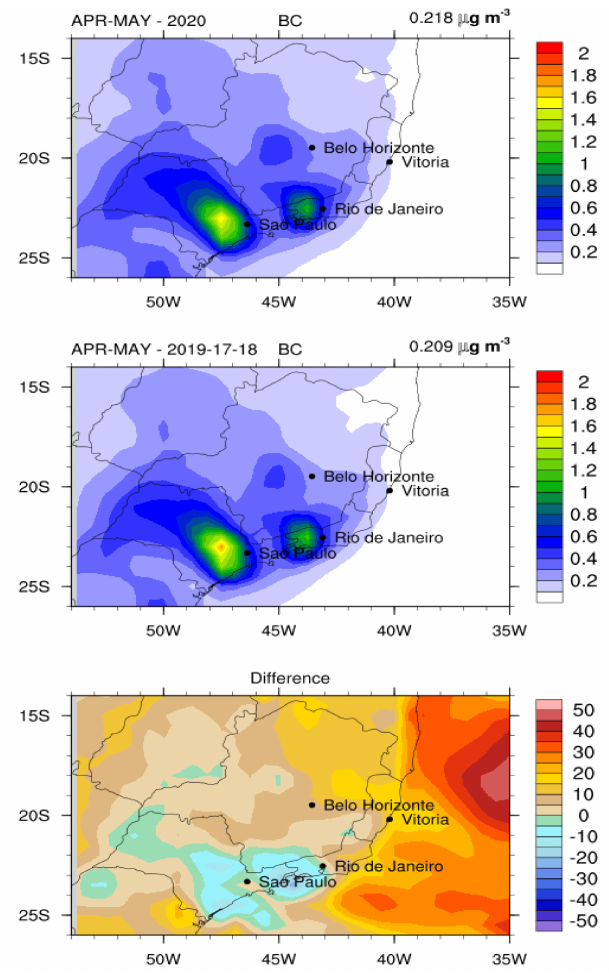
Figure 6. Concentration near the surface of BC for the period of April and May during the pandemic (2020) and pre-pandemic (2017–2019) from MERRA–2, and the percentage differences during the pandemic and pre-pandemic